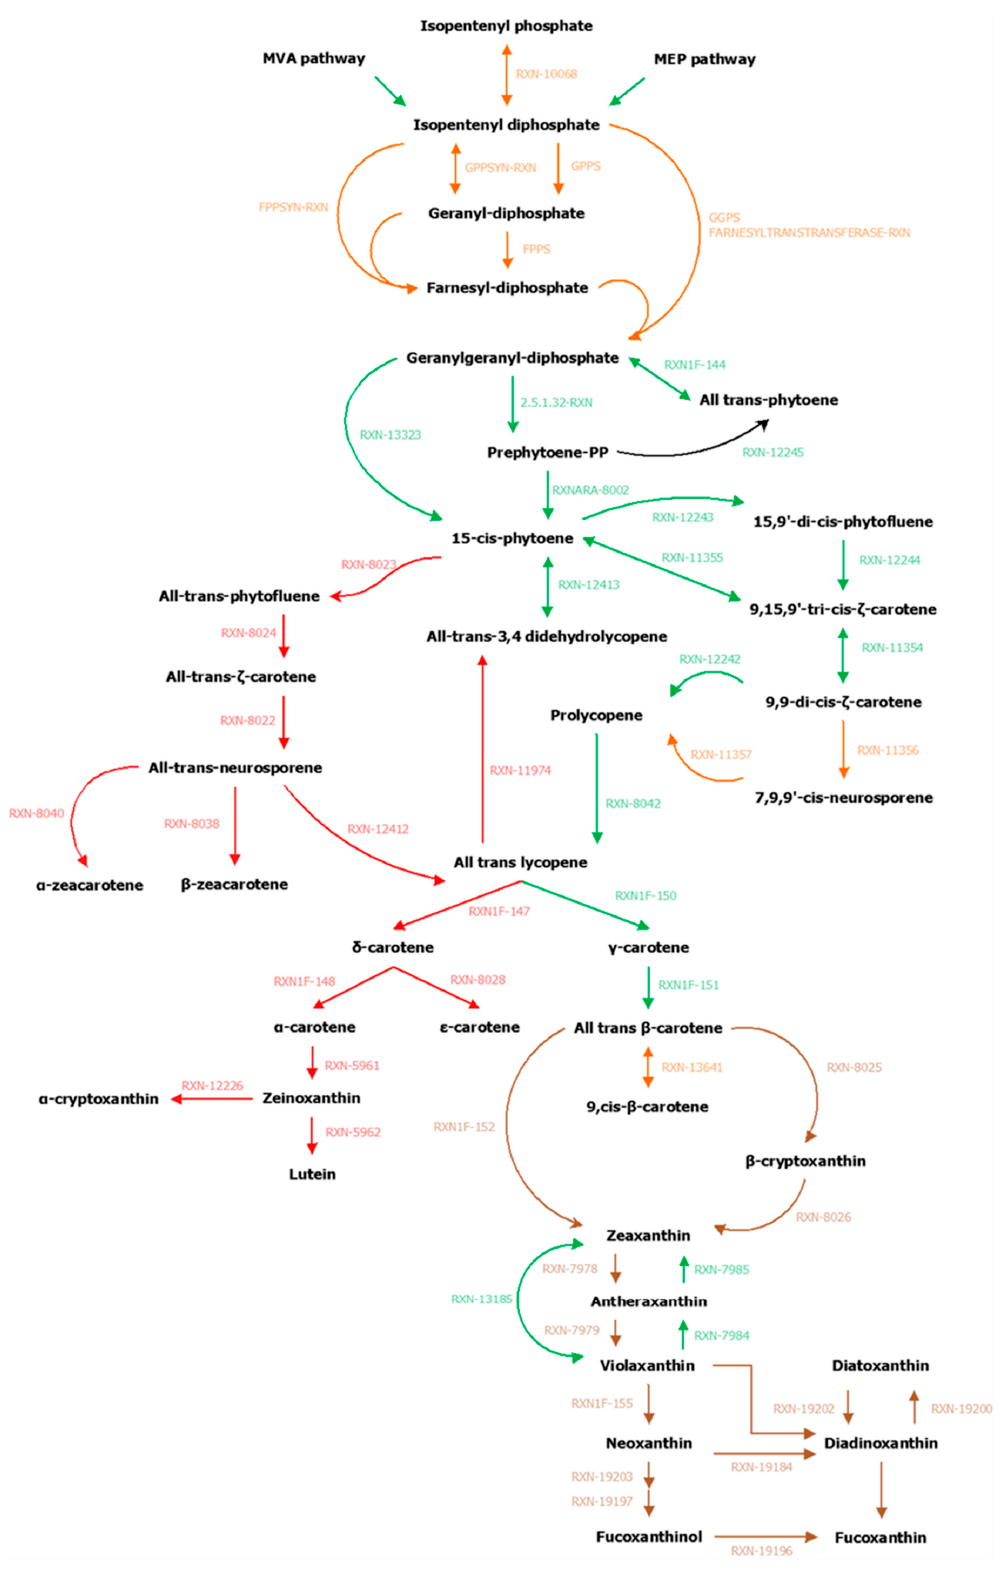
Figure A1. Reconstruction and manual curation of the genome–scale metabolic networks of S. japonica and C. okamuranus. In green, the reactions present initially in the GSMNs, in red those that were deleted, in brown those added, and in orange those to be